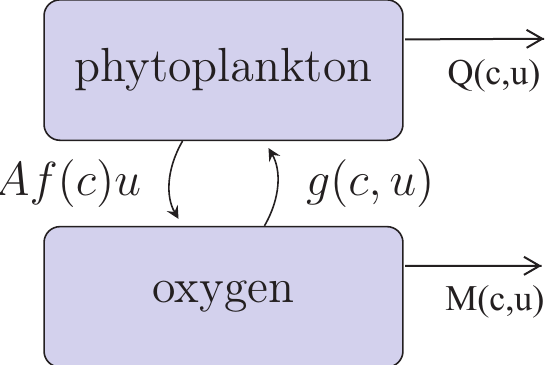
Figure 1. Flowchart diagram of mass flows between the components of the system (quantified by the growth rates Af ( c ) u and g ( c , u ) ) and losses of oxygen and phytoplankton due to their flows out of the system (quantified by M ( c , u ) and Q ( c , u ) , accordingly); see the details in the